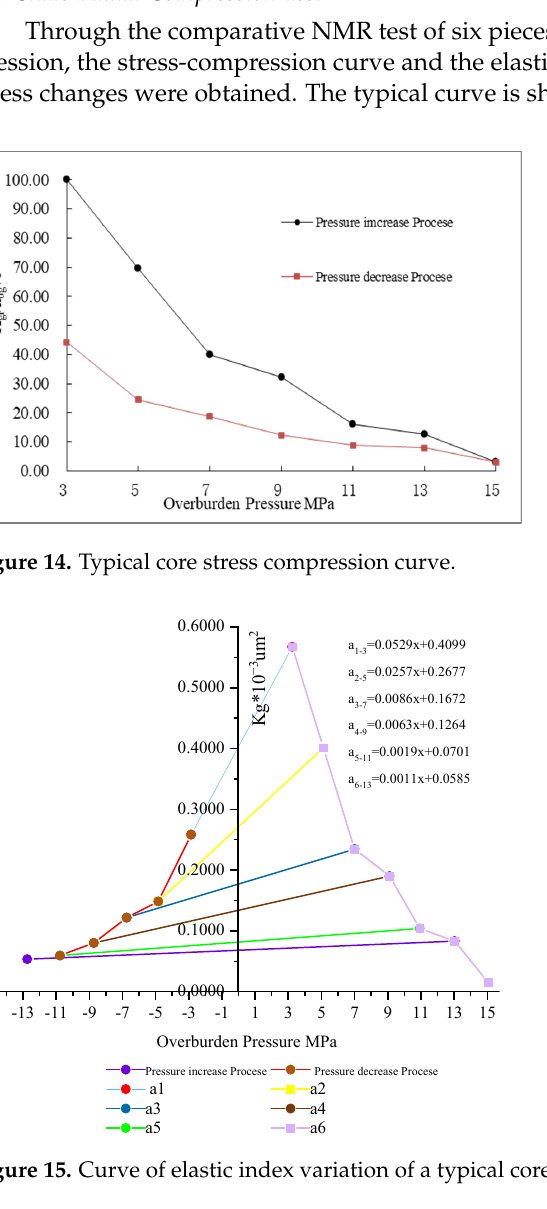
Figure 13. Histogram of the correlation distribution between static Young’s modulus and bulk modulus.